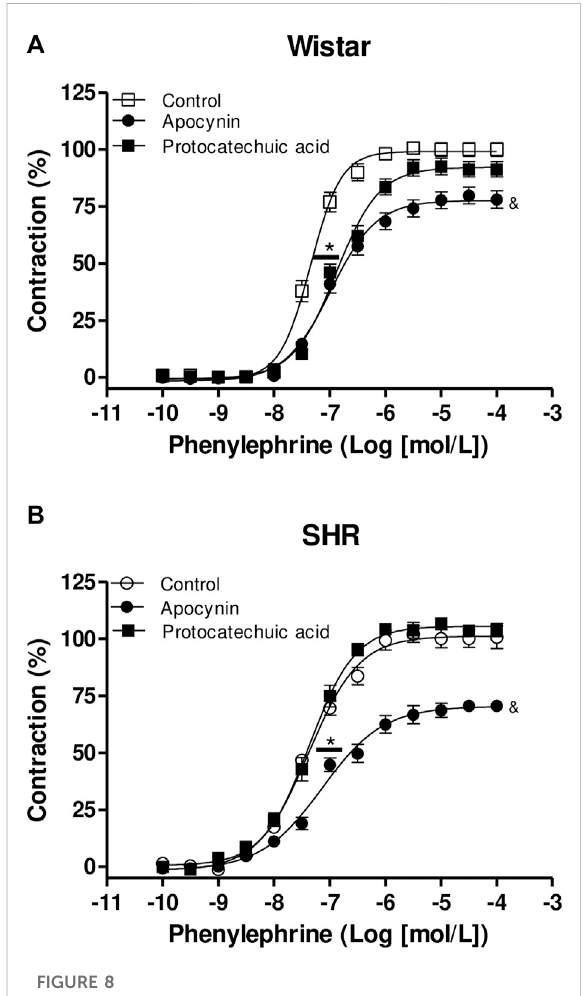
FIGURE 9 Cumulative concentration-effect curves to acetylcholine (0.1 nmol/L – 100 μ mol/L) in aorta rings from Wistar rats (A) and SHR (B) preincubated (100 μ mol/L)withapocynin(blackcircles) or protocatechuic acid (black squares) or not incubated (Control, white symbols). Values represent the mean ± SEM of the results, in percentage of relaxation, n = 3 – 7. * p < 0.05 SHR pD 2 values of Protocatechuic acid vs. Control, # p < 0.001 SHR pD 2 values of Apocynin vs. Control.